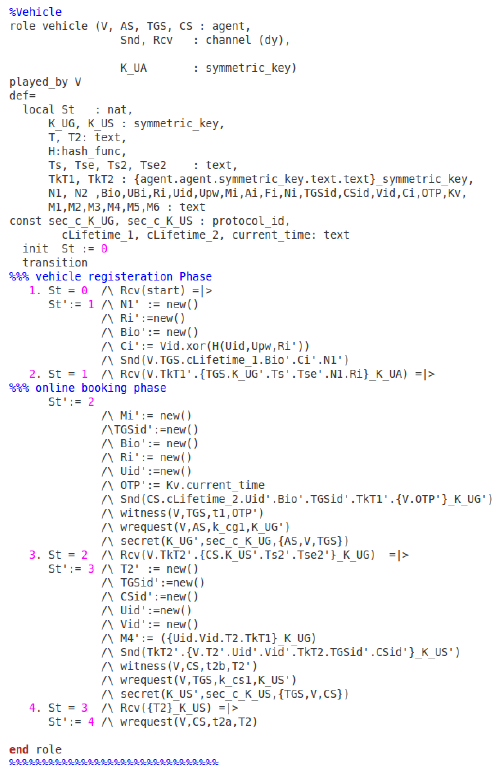
Figure 11. The vehicle’s role in HLPSL.